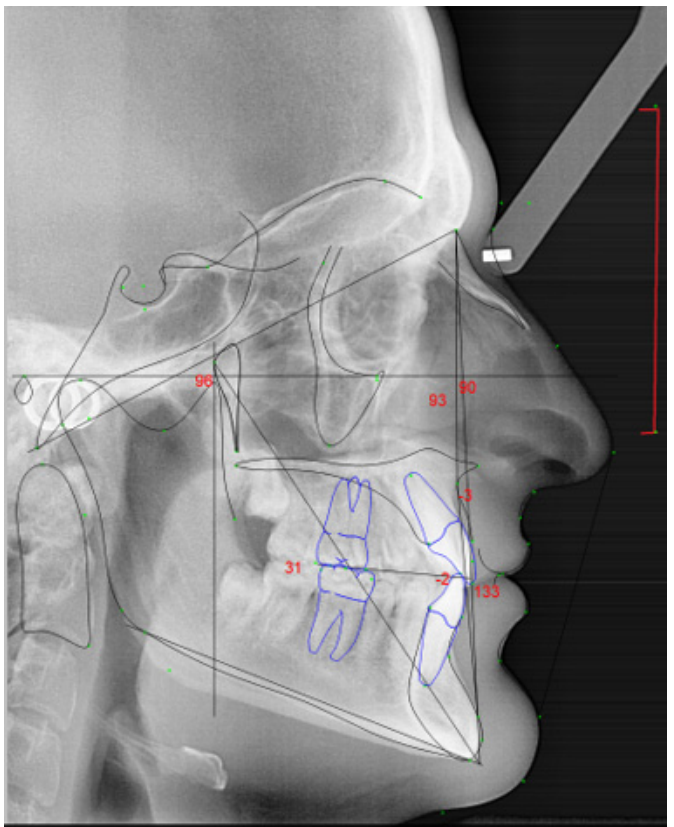
Figure 1. Lateral tele-radiography of the head for dentofacial cephalometric analysis.